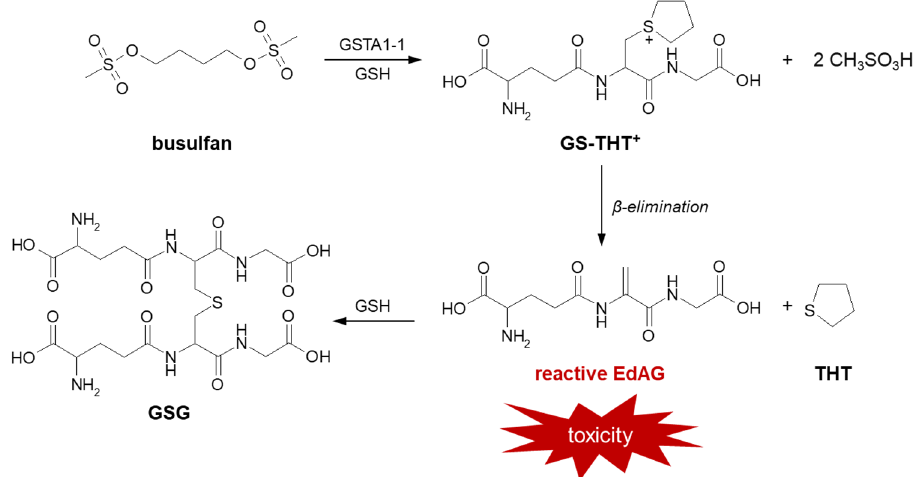
Figure 18. Formation of reactive busulfan metabolites in a GSH-dependent pathway [170]. EdAG = γ -glutamyl-dehydroalanyl-glycine; GSG = EdAG-GSH S-conjugate; GSH = glutathione; GST = glutathione S-transferase; GS-THT + = glutathionyl-tetrahydrothiophene; THT = tetrahydrothiophene.